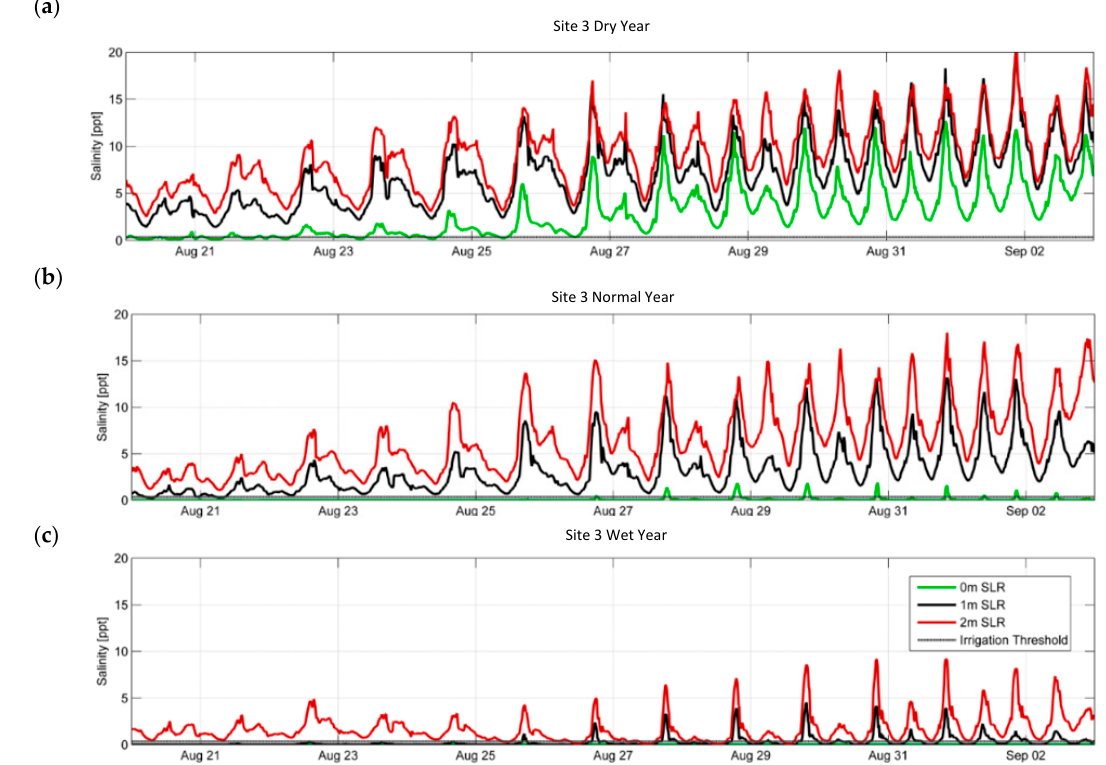
Figure 16. Surface salinity at site 3 in August with 0–2 m SLR. ( a ) dry year; ( b ) normal year; ( c ) wet year.